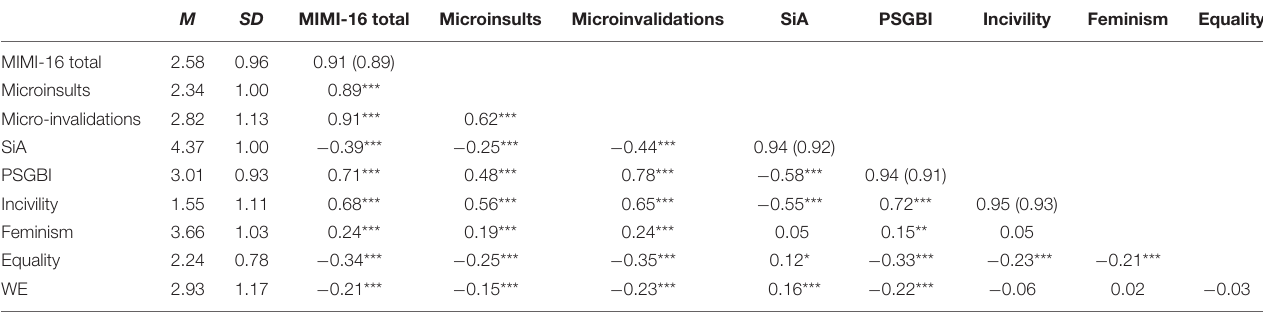
TABLE 2 | Descriptives and inter-correlations for study 1.